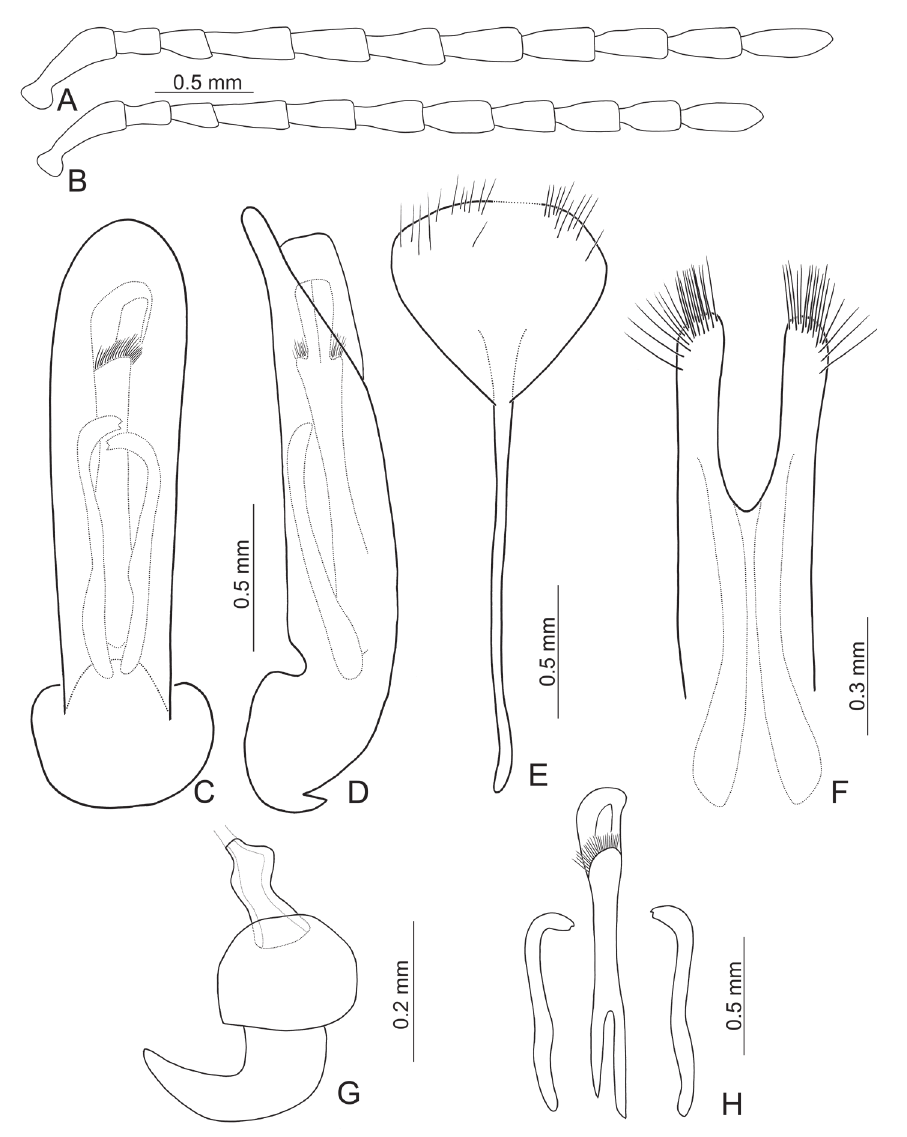
Figures 14. Diagnostic characters of Gallerucida thoracica (Jacoby). A Antenna, male B Antenna, fe- male C Penis, dorsal view D Penis, lateral view E Abdominal ventrite VIII F Gonocoxae G Spermatheca H Endophallic